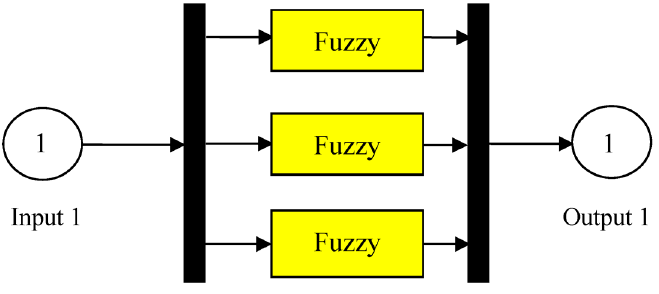
Figure 6. Schematic diagram of the FLC hysteresis comparators.